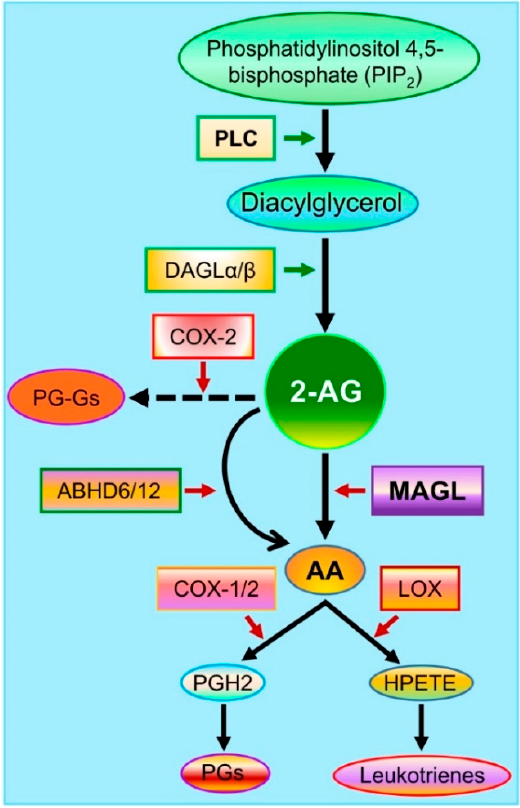
Figure 2. Major pathways of 2-AG synthesis and metabolism. Membrane phospholipids are converted to diacylglycerol (DAG) by phospholipase C (PLC) and then to 2-AG by diacylglycerol lipases (DAGL α and β ). The compound 2-AG is hydrolyzed by the enzymes monoacylglycerol lipase (MAGL) and α / β hydrolase domain-containing proteins 6 and 12 (ABHD6/12) to glycerol and arachidonic acid (AA) and oxidatively metabolized by cyclooxygenase-2 (COX-2) to form a new type of prostaglandin glycerol esters (PG-Gs). AA is a precursor of prostaglandins (PGs) through the enzymes COX-1/2 and of hydroperoxyeicosatetraenoic acid (HPETE) through the enzyme arachidonate 5-lipoxygenase (LOX) to form leukotrienes.